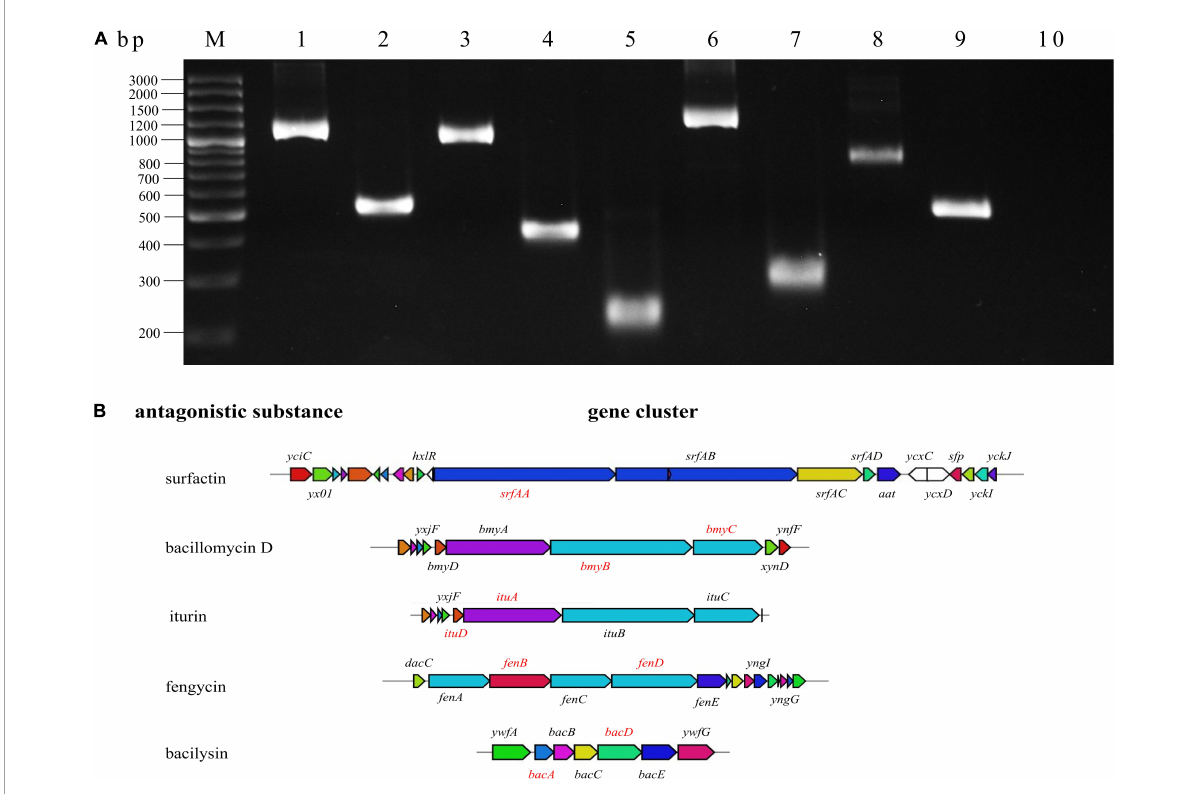
FIGURE6 Amplification of antimicrobial peptide synthesis gene of B. velezensis BR-01. (A) Detection of antimicrobial peptide biosynthetic gene in B. velezensis BR-01 by PCR. M, DNA marker; 1, ituA ; 2, ituD ; 3, bmyC ; 4, bmyB ; 5, srfAA ; 6, fenB ; 7, fenD ; 8, bacD ; 9, bacA ; 10, non-template control. (B) Five antimicrobial peptide biosynthetic gene clusters. The red gene denote the successful antibacterial peptide biosynthesis gene amplified by PCR. Pictures of antimicrobial peptide gene cluster were from antiSMASH